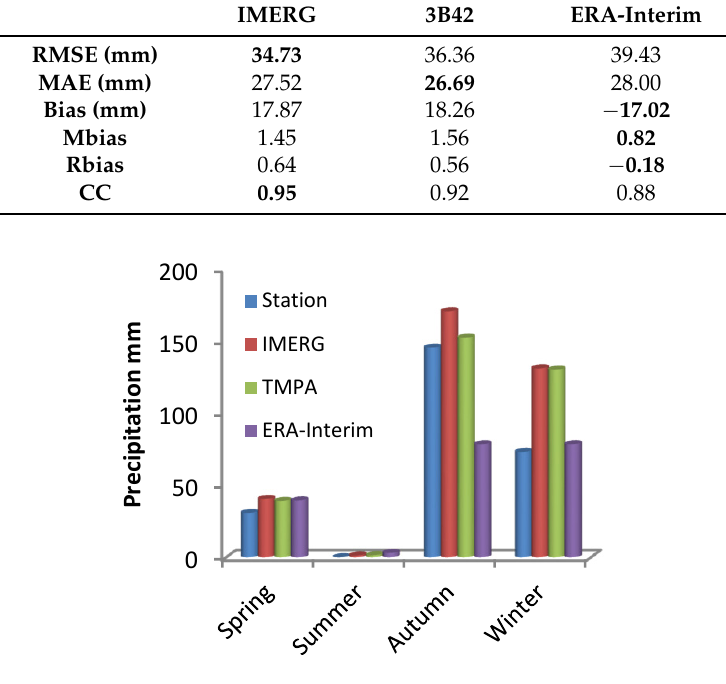
0.92 Figure 13. Bushehr seasonal precipitation.